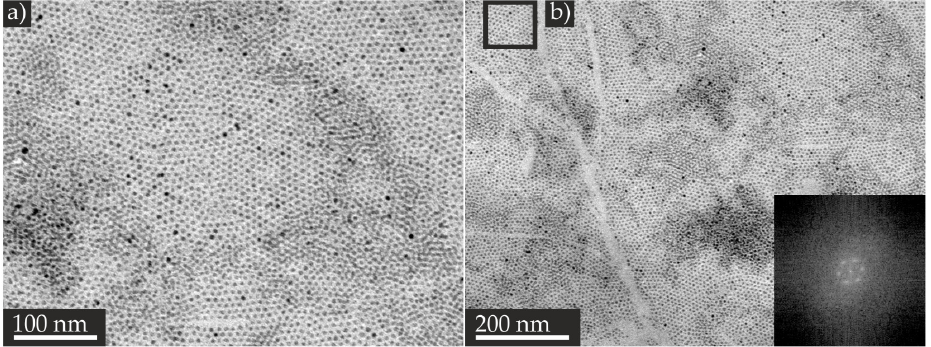
Figure 3. Representative TEM images of the self-assembled TiO 2 NP film with decreasing magnification ( a , b ). The inset in ( b ) shows the fast Fourier transformation of the black highlighted area of the monolayer.